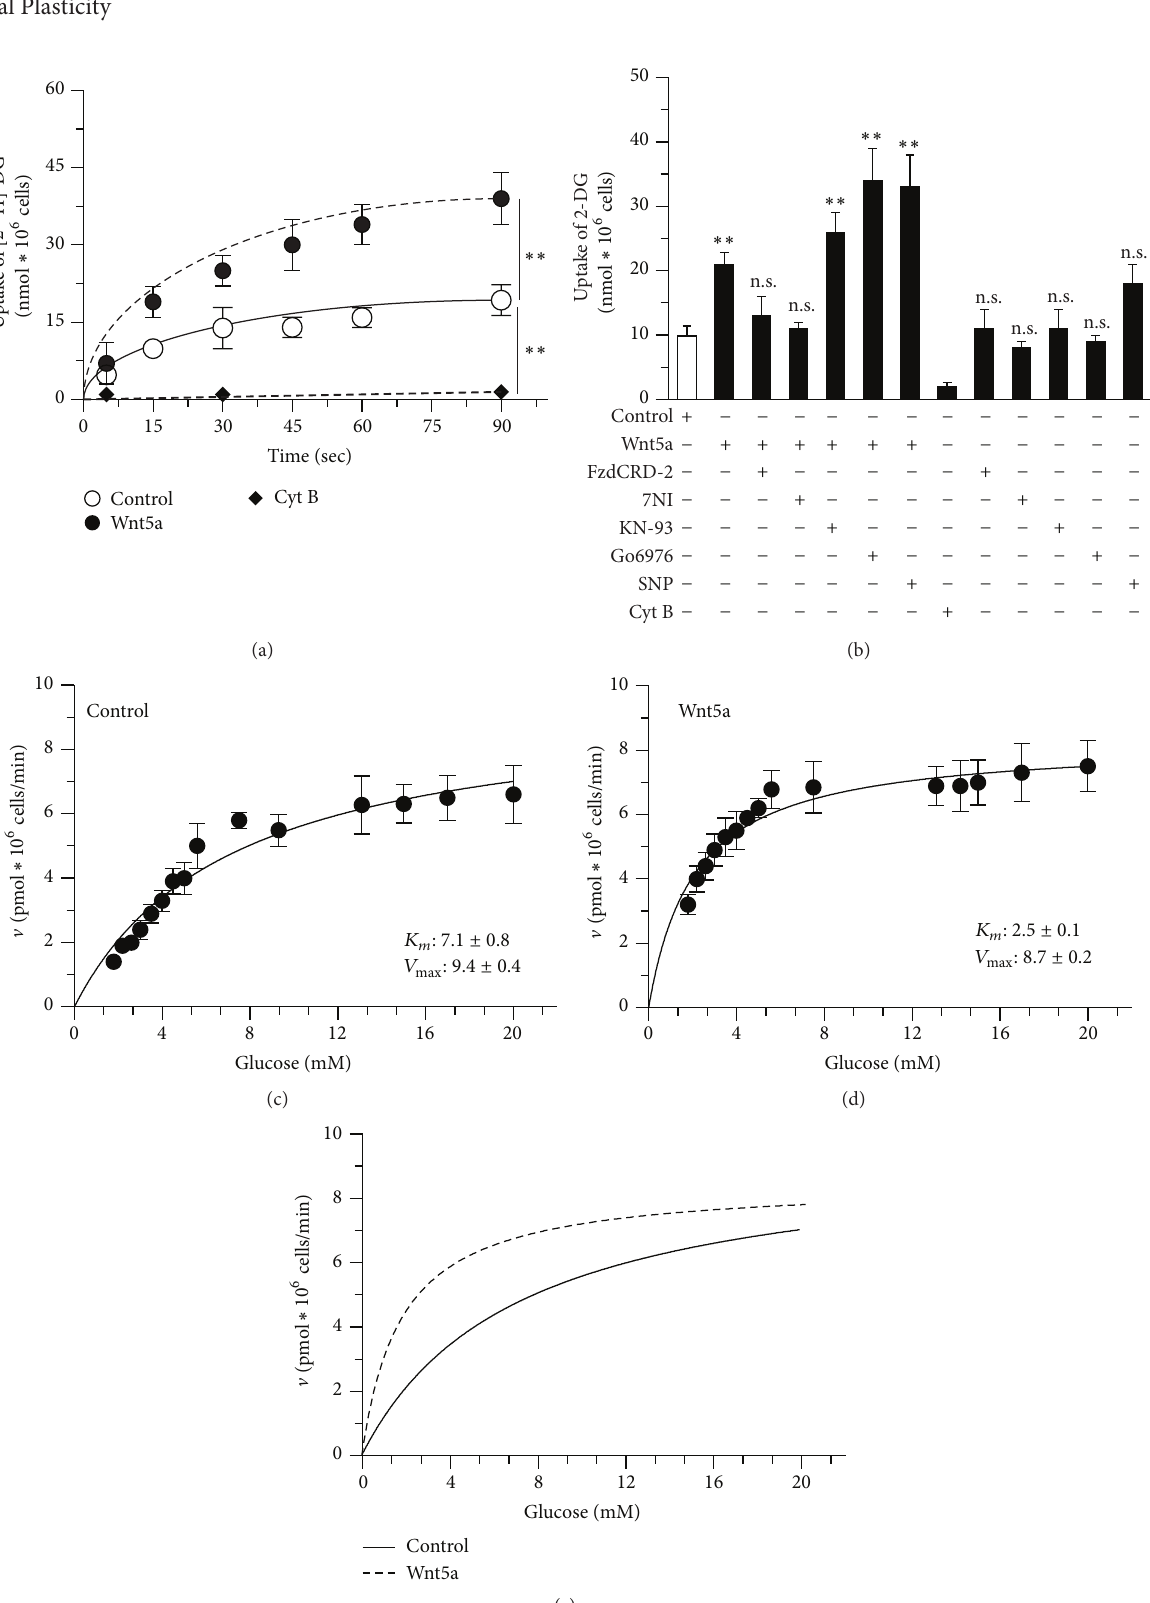
Figure 1: Wnt5a stimulates glucose uptake. (a) Treatment with Wnt5a stimulates the uptake of 2-DG in a time-dependent manner. (b) The effect of Wnt5a was blocked by the antagonist FzCRD2 and with 7NI a nNOs inhibitor. (c–e) The initial uptake of tracer amounts of 2-DG (at 15sec.) was measured in the presence of increasing concentrations of unlabeled glucose (0–30 mM), under the control condition (c) and in cells treated with Wnt5a (d). Representative plot of both conditions (e). Data represent the mean ± SEM of 𝑛 = 4 , each performed in triplicate. ∗∗ 𝑝 < 0.005 , Bonferroni